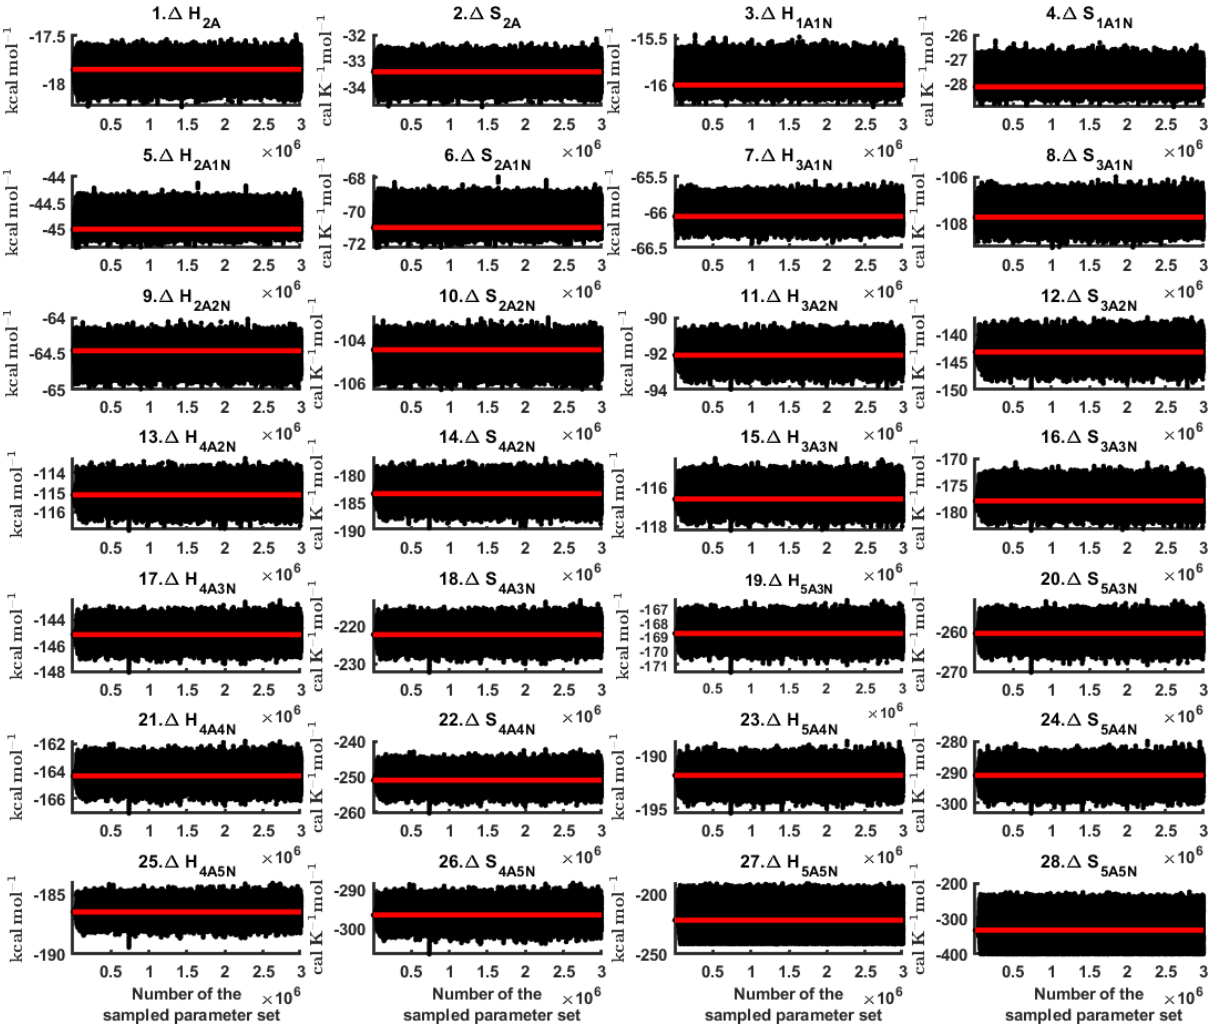
Figure D2. Parameter chains of the cluster formation enthalpies (units given in kcalmol − 1 ) and entropies (units given in calK − 1 mol − 1 ) determined from steady-state cluster concentration measurements at two temperatures ( T = 278K and T = 292K). Red lines denote the baseline values from Olenius et al. (2013b) used to generate the synthetic data. Here, the symbols (cid:49) H and (cid:49) S stand for cluster formation enthalpies and entropies, respectively. The notation xAyN corresponds to a cluster with x sulfuric acid and y ammonia